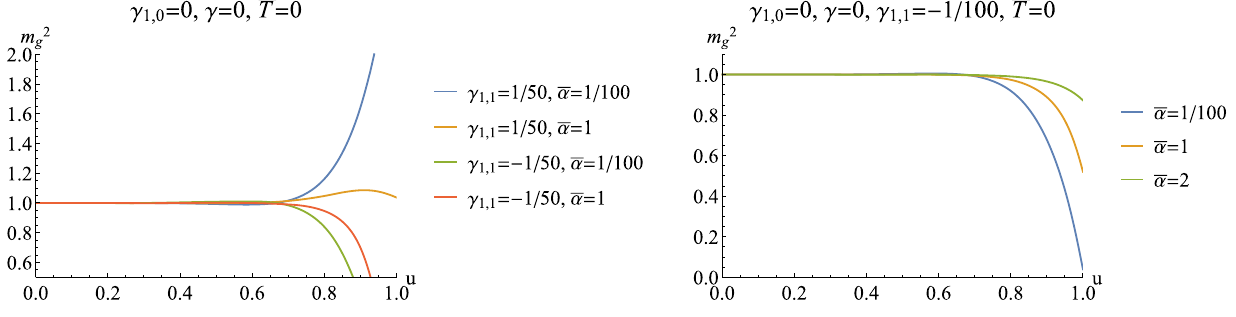
Fig. 29 Left plot: m 2 g as a function of u at zero temperature for representative ¯ α and γ 1 , 1 ( γ 1 , 0 = 0 and γ = 0). Right plot: m 2 g as a function of u at zero temperature for γ 1 , 1 = − 1 / 100 and different ¯ α ( γ 1 , 0 = 0 and γ = 0) γ 1 , 1 reaches its lower bound set at zero charge density, m becomes negative for u approaching the horizon.